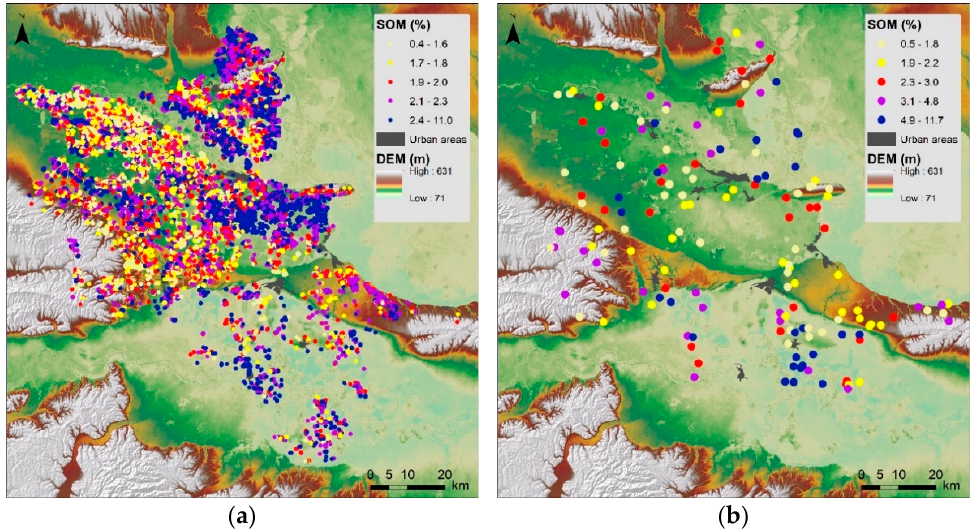
Figure 2. Geographical distribution of soil samples for SOM2010 ( a ) and SOM1970 ( b ). Classes of soil content based on quantiles (20% each class).